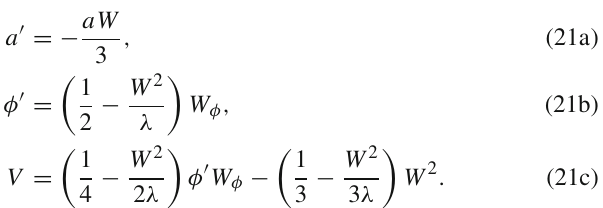
gets B = 6 /λ , α = 1 − 3 γ , and β = − 2 γ , with γ a